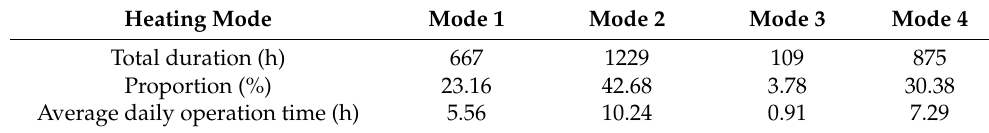
Table 4. Total operation time and proportion of different heating modes in the heating period.